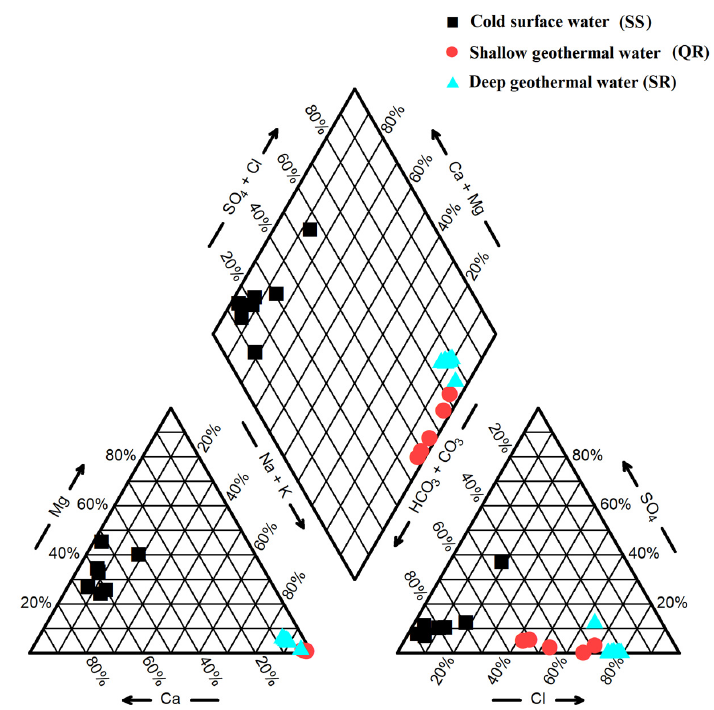
Figure 2. Piper diagram showing the composition of the geothermal fluids.